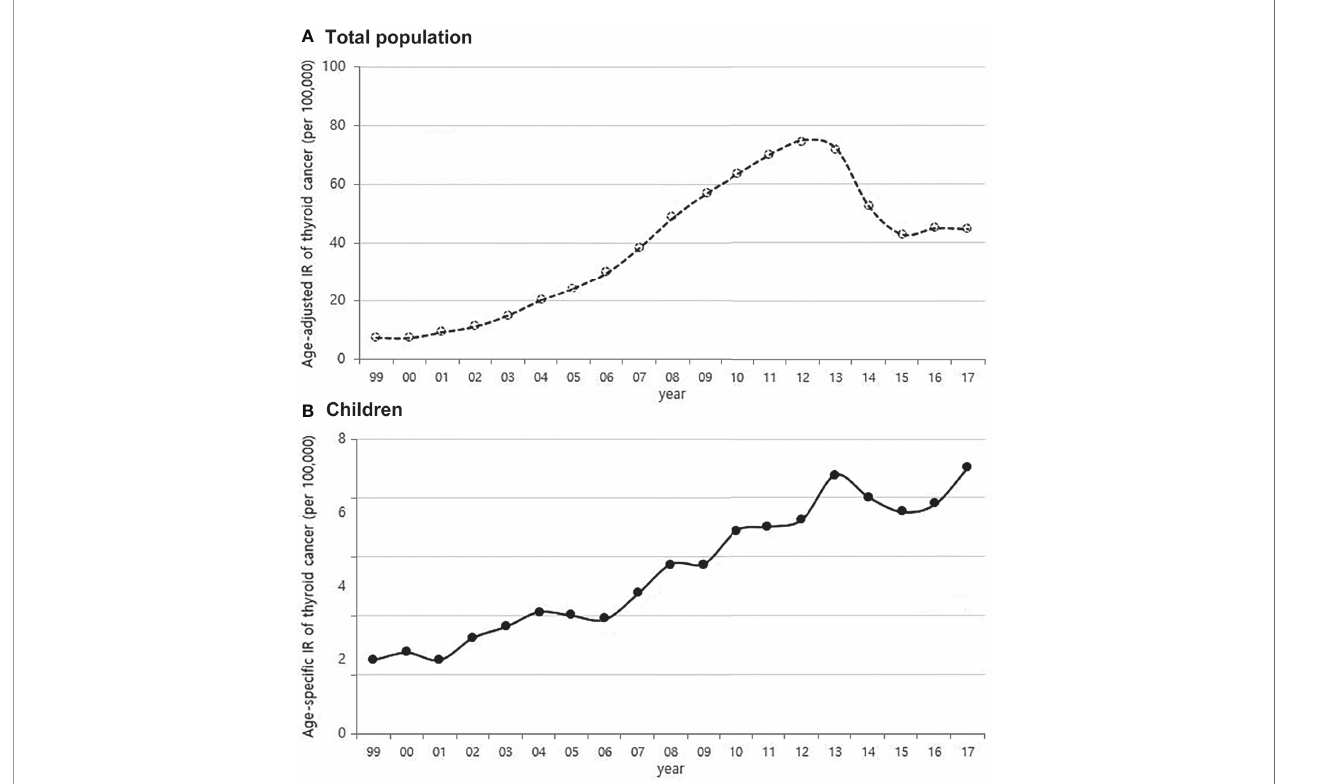
FIGURE 1 | Age-adjusted incidence of thyroid cancer in Korea (A) and age-speci fi c incidence rate of childhood thyroid cancer (0-18 years) (B) (1999-2017, per population of 100,000). IR, incidence